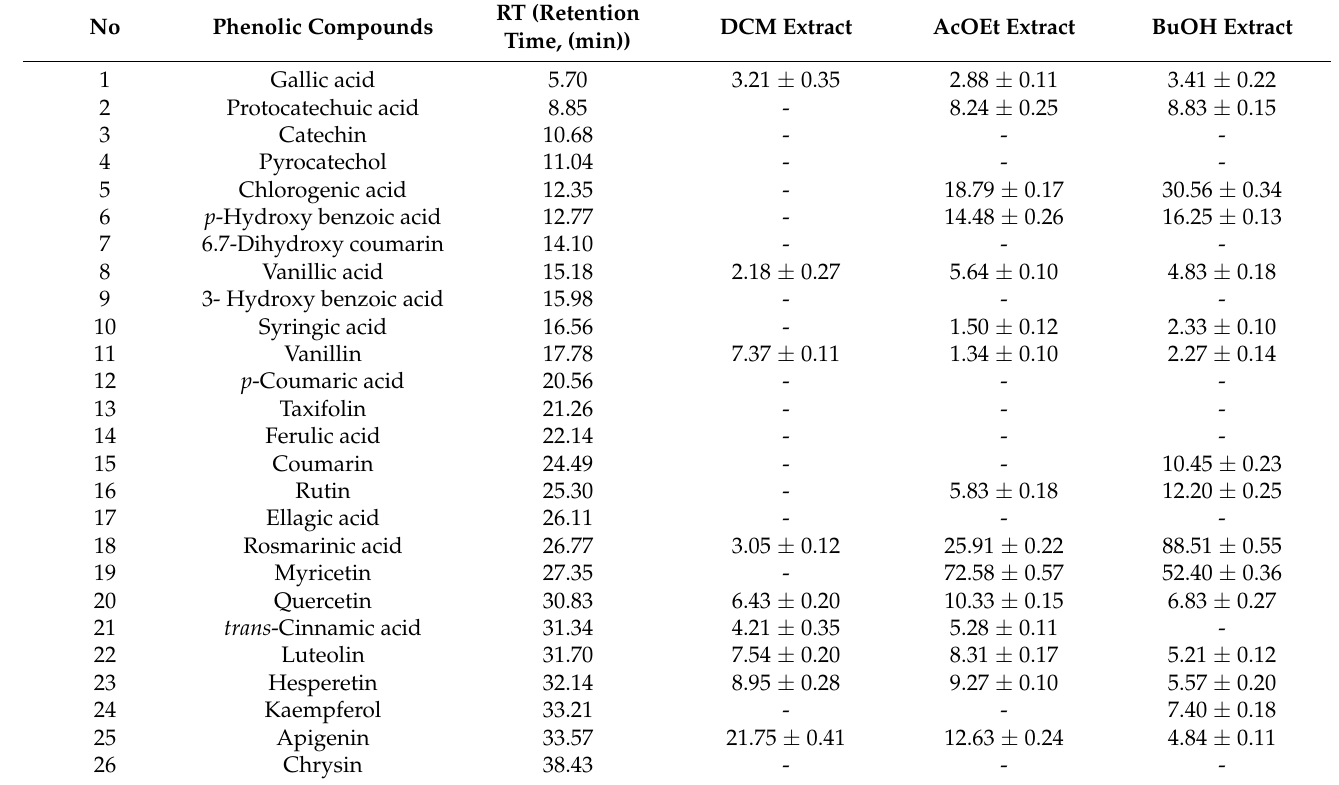
Table 1. Composition of C nepeta extracts in phenolic compounds determined by HPLC-DAD ( µ